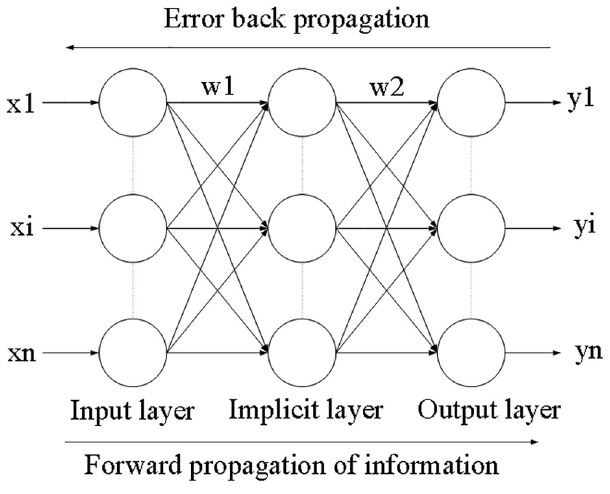
Fig 1. BP neural network structure